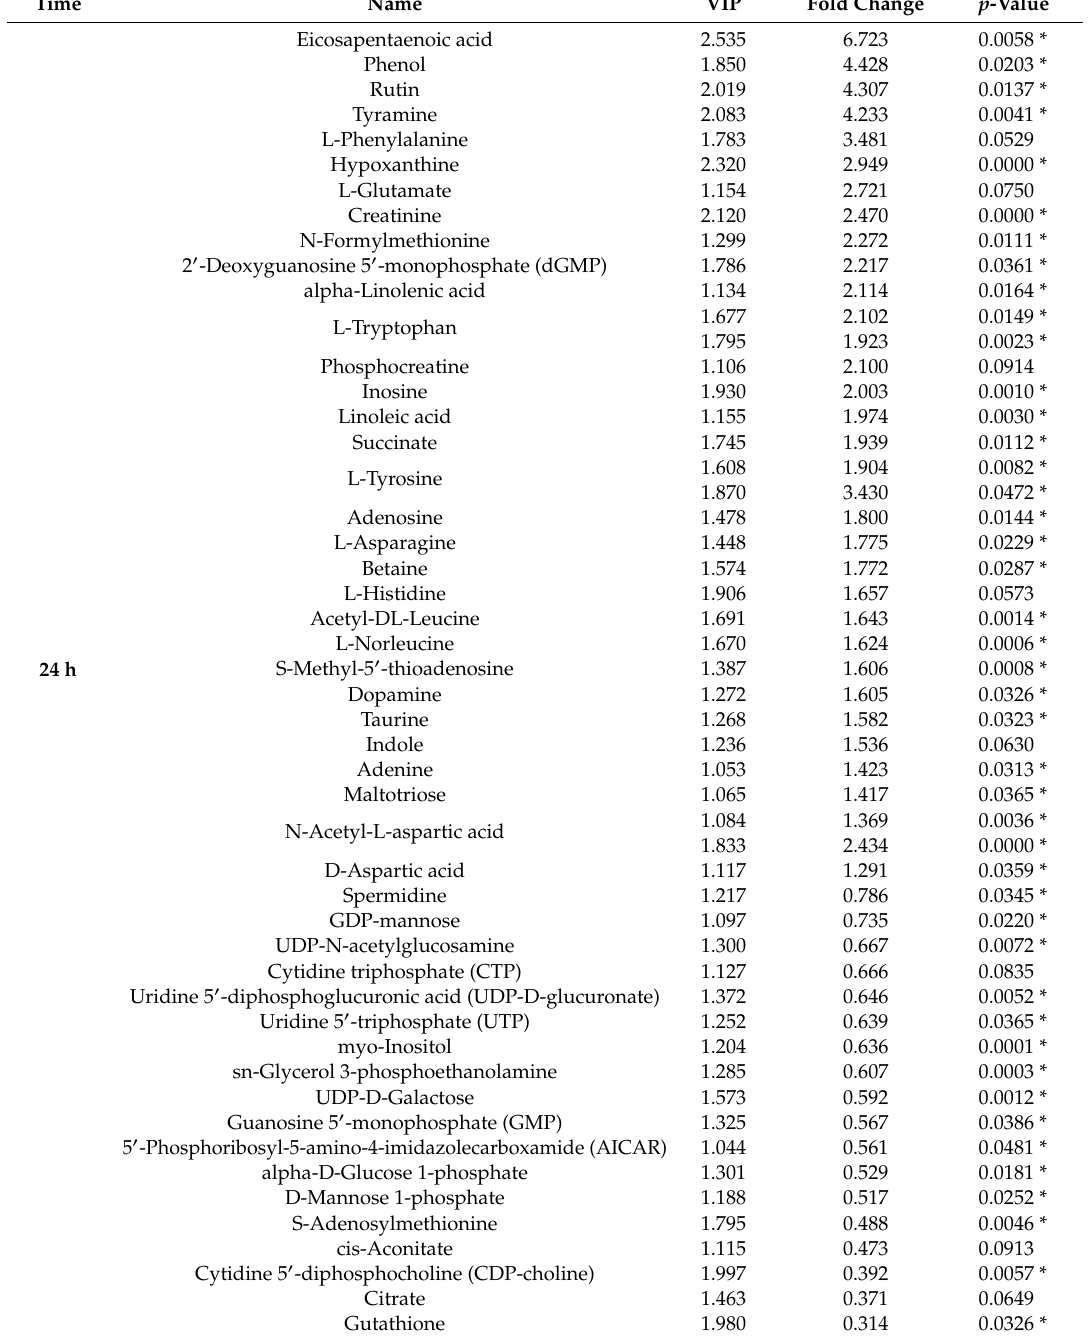
Table 3. List of di ff erential metabolites in the ISKNV infection groups compared to the control groups.